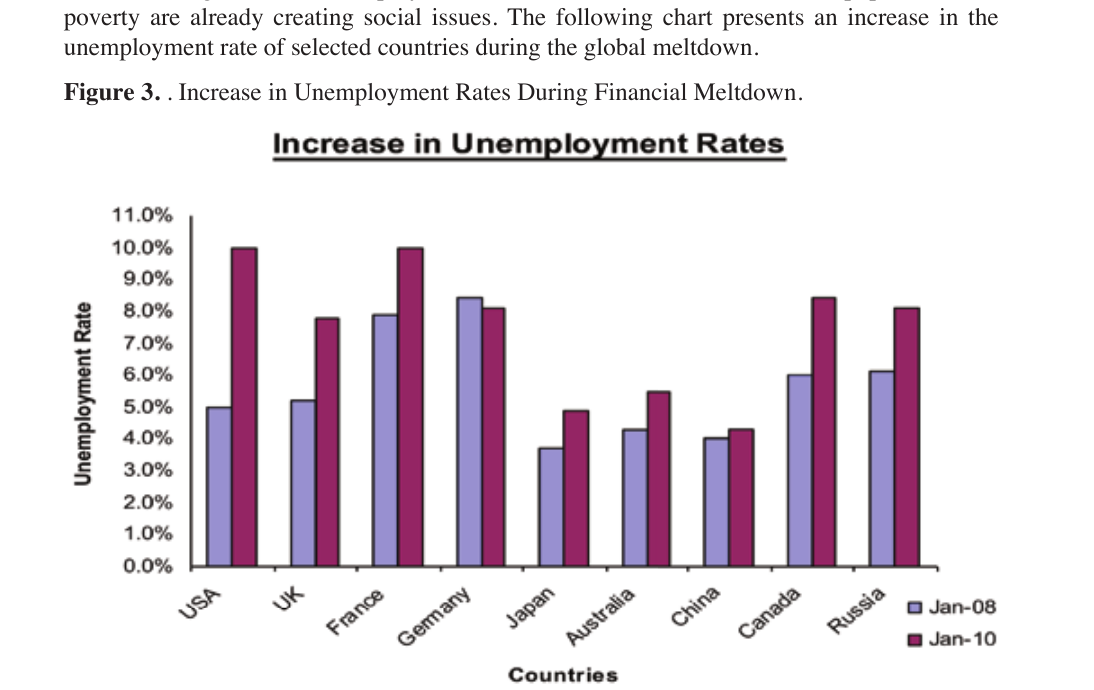
Figure 3. . Increase in Unemployment Rates During Financial Meltdown.